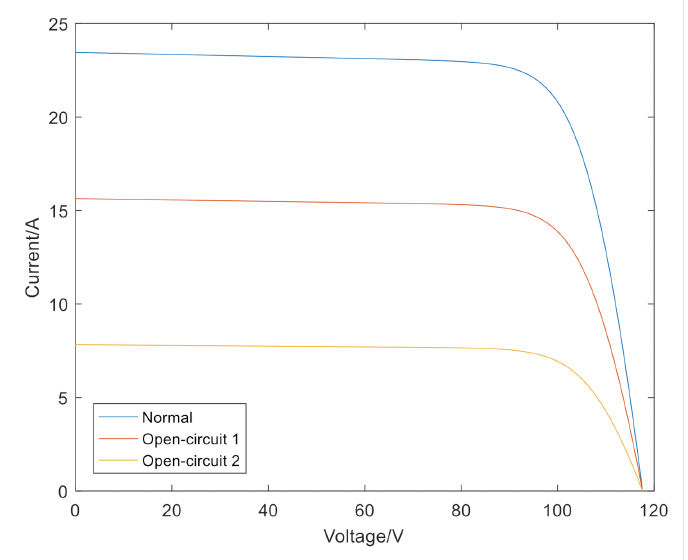
Figure 3. I-V curves of the PV array in case of the open-circuit faults. Short-circuit fault: Short-circuit faults are caused by an accidental connection between two nodes of the PV array. The reasons for this failure are insulation aging or damage, water in the junction box, or lightning current that burns the insulator. This fault will cause the faulty string voltage to decrease, resulting in a significant decrease in output power. This paper simulates the I-V curves of two kinds of short-circuit faults, i.e., one and two components in a series of PV arrays are short-circuited respectively. The normal and fault I-V curves are shown in Figure 4. It is obvious that as the short-circuit fault occurs, the open-circuit voltage and maximum power greatly decrease, while the short-circuit current remains unchanged.